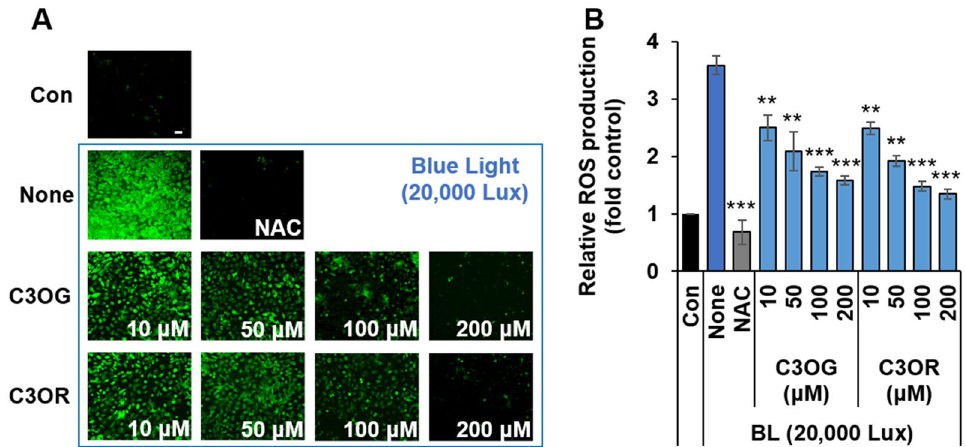
Fig. 2 Effects of C3OG and C3OR on ROS production in HaCaT cells exposed to blue light. HaCaT cells cultured in 96‑well plates were exposed to blue light (20,000 lx) for 1 h and then stained with H 2 DCFDA ( A, B) . HaCaT cells were pre‑treated with the indicated concentrations of C3OG or C3OR for 24 h or with NAC (10 mM) for 1 h prior to exposure to blue light ( A, B) . The generation of ROS was visualized using a fluorescence microscope, Scale bar, 100 μm ( A) , or measured using a fluorescence plate reader ( B ). The bar graph presents the fold changes in ROS production in cells exposed to blue light relative to the unexposed control cells ( n 3, SD). ** p < 0.01 and *** p < 0.001 vs. blue light (20,000 = ±